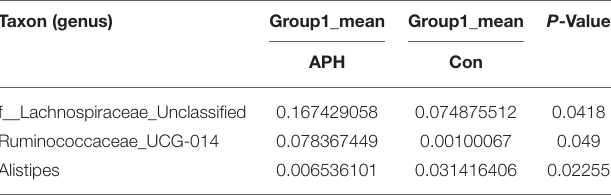
TABLE 10 | Based on Metastats analysis for flora differences between APM and AMXM on groups under the genus.